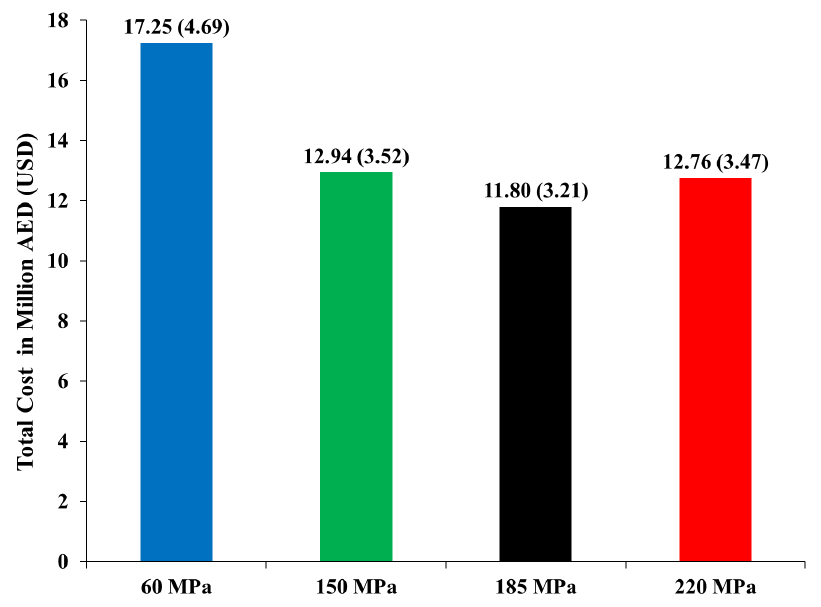
Figure 8. Total cost in AED (USD).